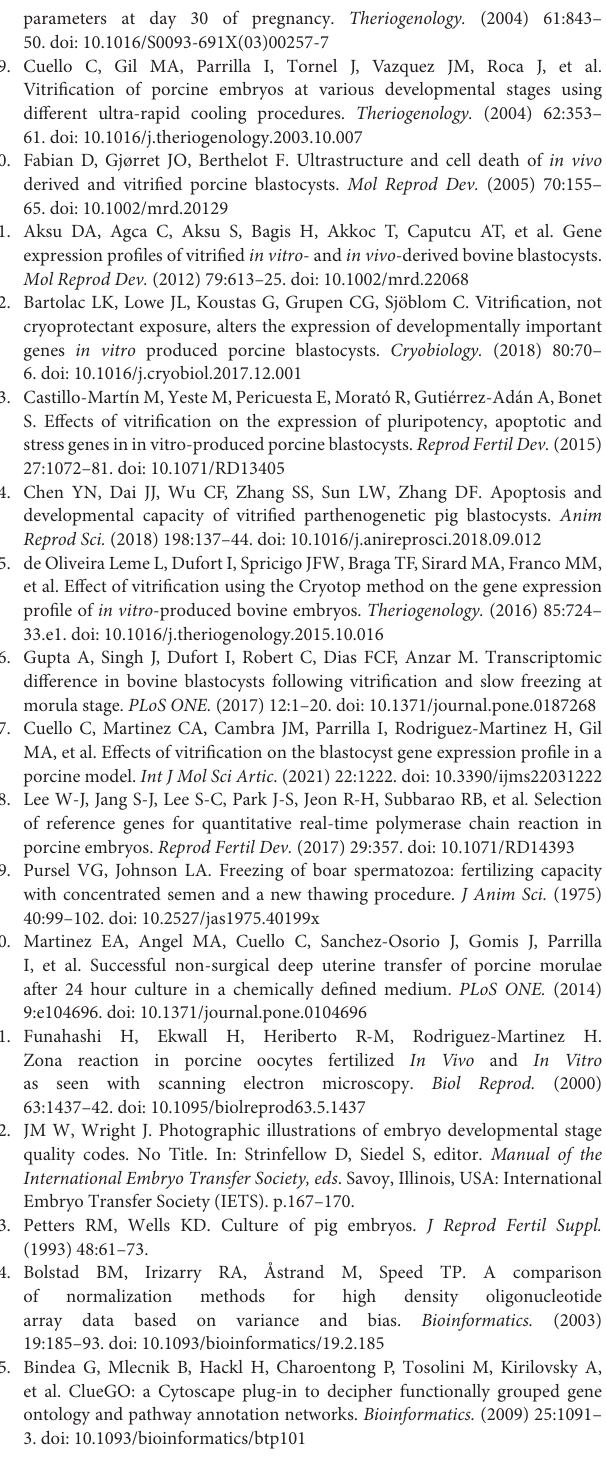
Supplementary Figure 1 | Principal component analysis (PCA) of the microarray-based gene expression profiles of vitrified (red; n = 3) and control (blue; n = 3) morulae. Each data sphere represents a microarray-A three principal component is